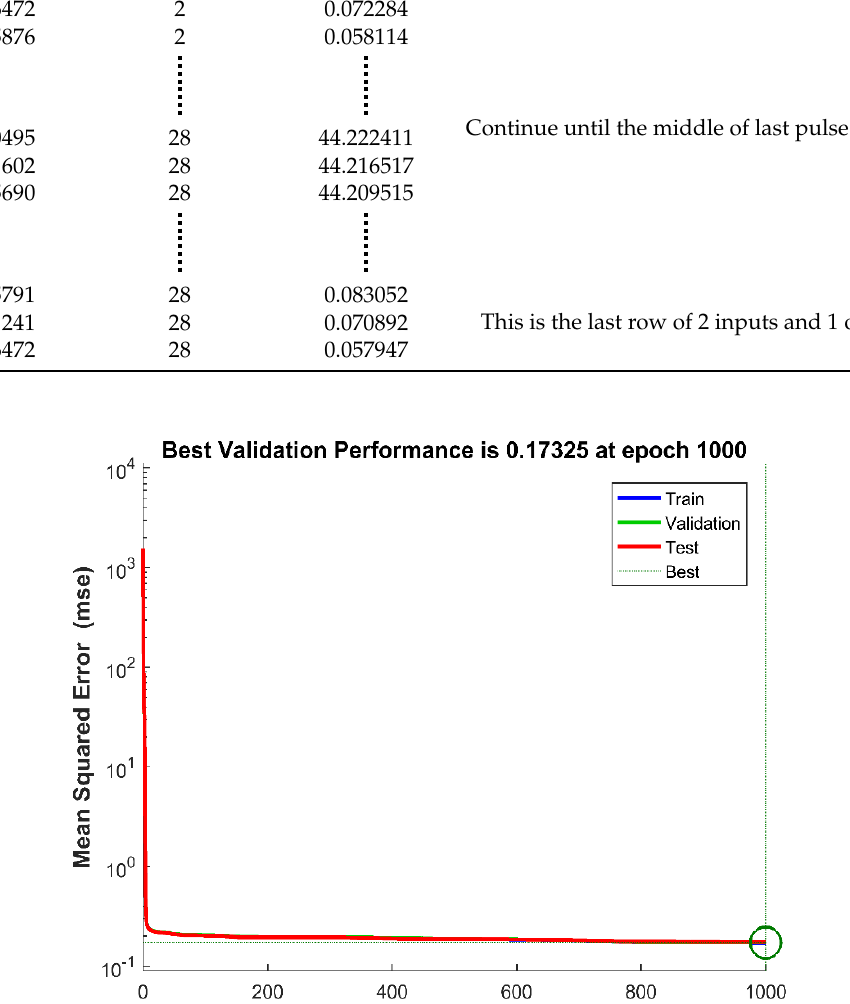
Table 2. The inputs and target data set used for neural network training.